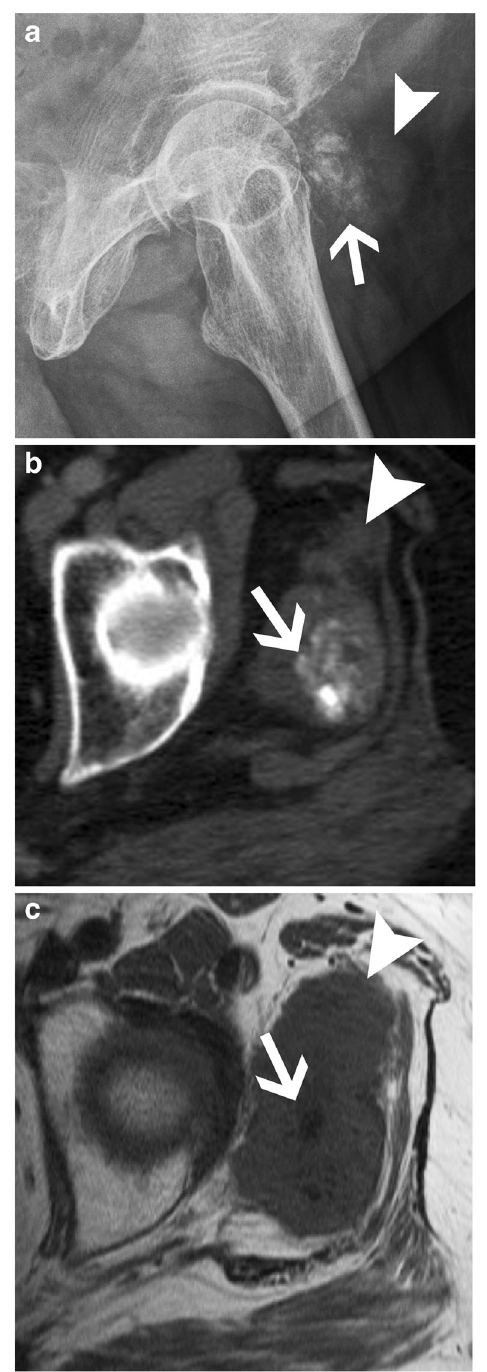
Fig. 25 Synovial sarcoma. ( a ) Frog-leg radiograph, ( b ) axial CT image and ( c ) axial T1-weighted image of the left thigh show faint calcifications (arrow in a , b and c ) that are located inside a tumour which is better seen on the CT and MRI assessment (arrowhead in a , b and c ). Synovial